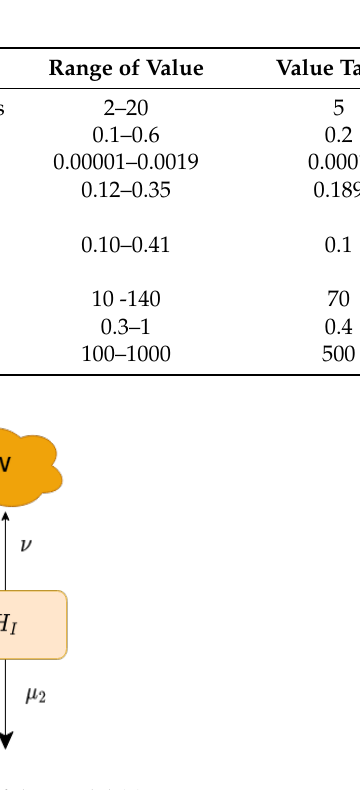
Figure 1. Schematic diagram of the infection process of the model